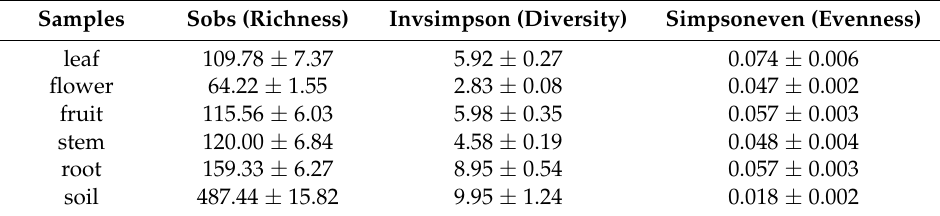
Table 1. Richness, diversity and evenness indexes of fungal communities (mean ±